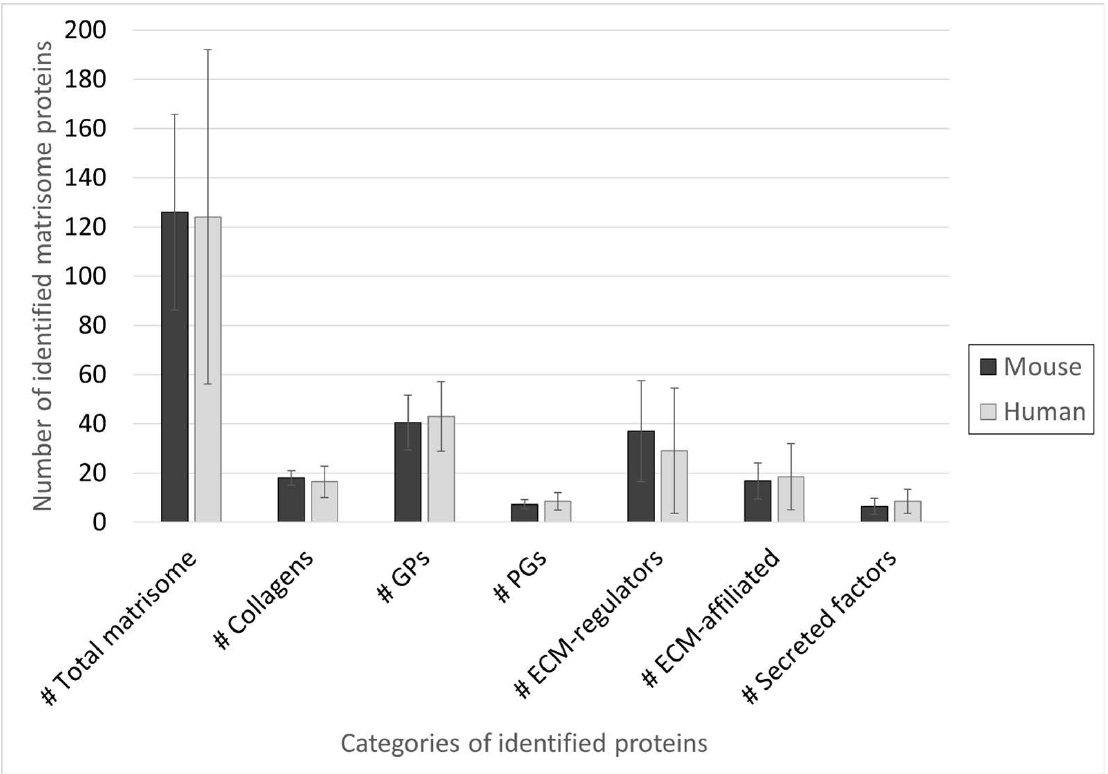
Figure A2. The average composition of the matrisome revealed in mouse and human kidney samples by different studies, including the current study, and the following publications by McCabe et al. [20], Lipp et al. [28], Liu et al. [30], Louzao-Martinez et al. [31], and Randles et al. [32]. The bar graphs show Mean ± Standard Deviation of the number of proteins in each category averaged across the species-specific data reported in Table A9. Abbreviations: #—number of; GPs—ECM Glycoproteins;